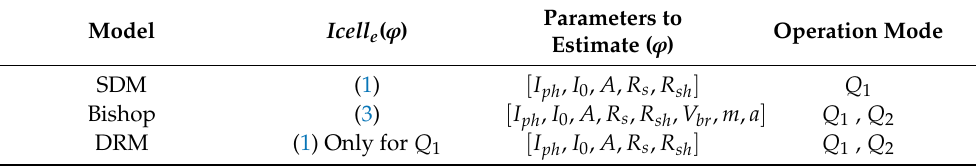
Table 1. Evaluation of the estimated I cell for each model.